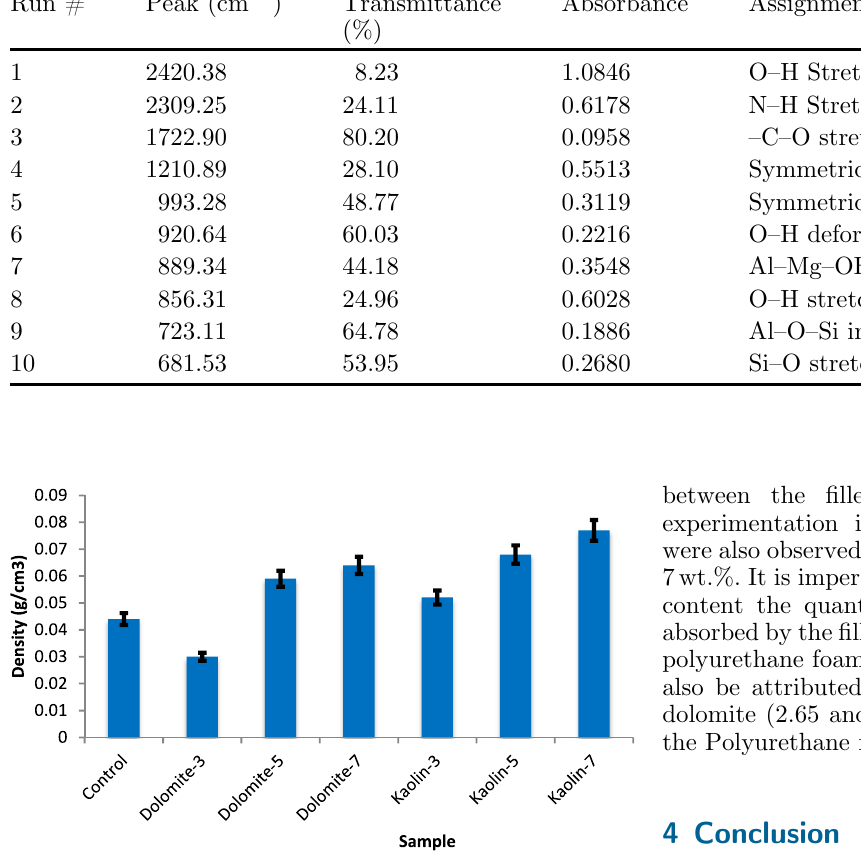
Fig. 10. Densities the dolomite and kaoline fi lled polyurethane foam.